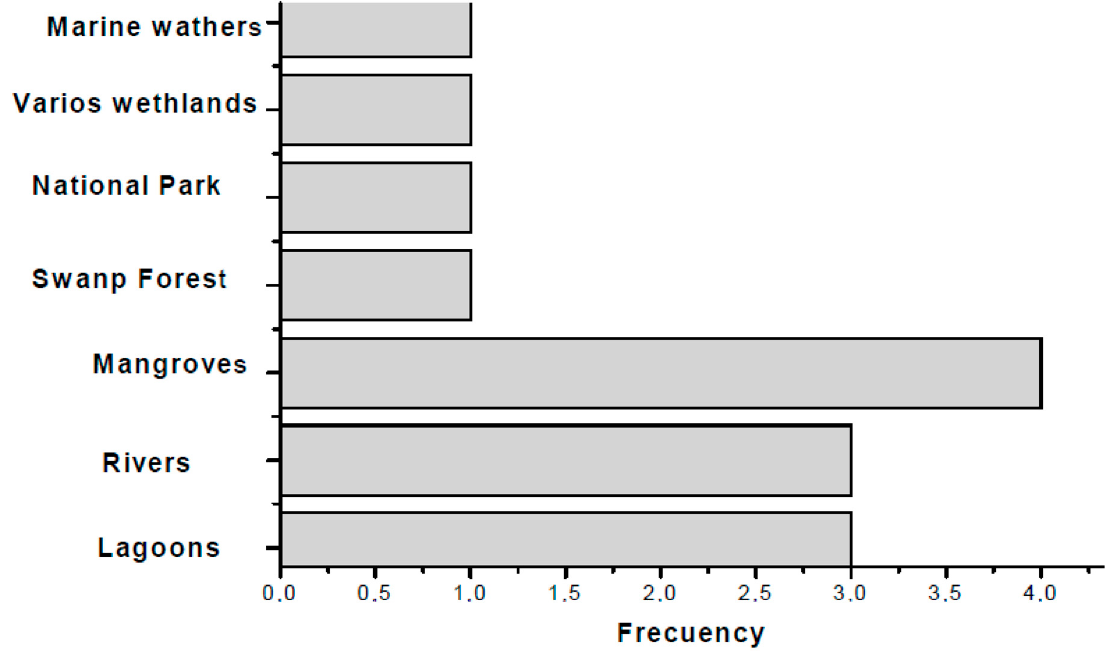
Figure 12. Frequency Distribution of the type of wetlands affected in